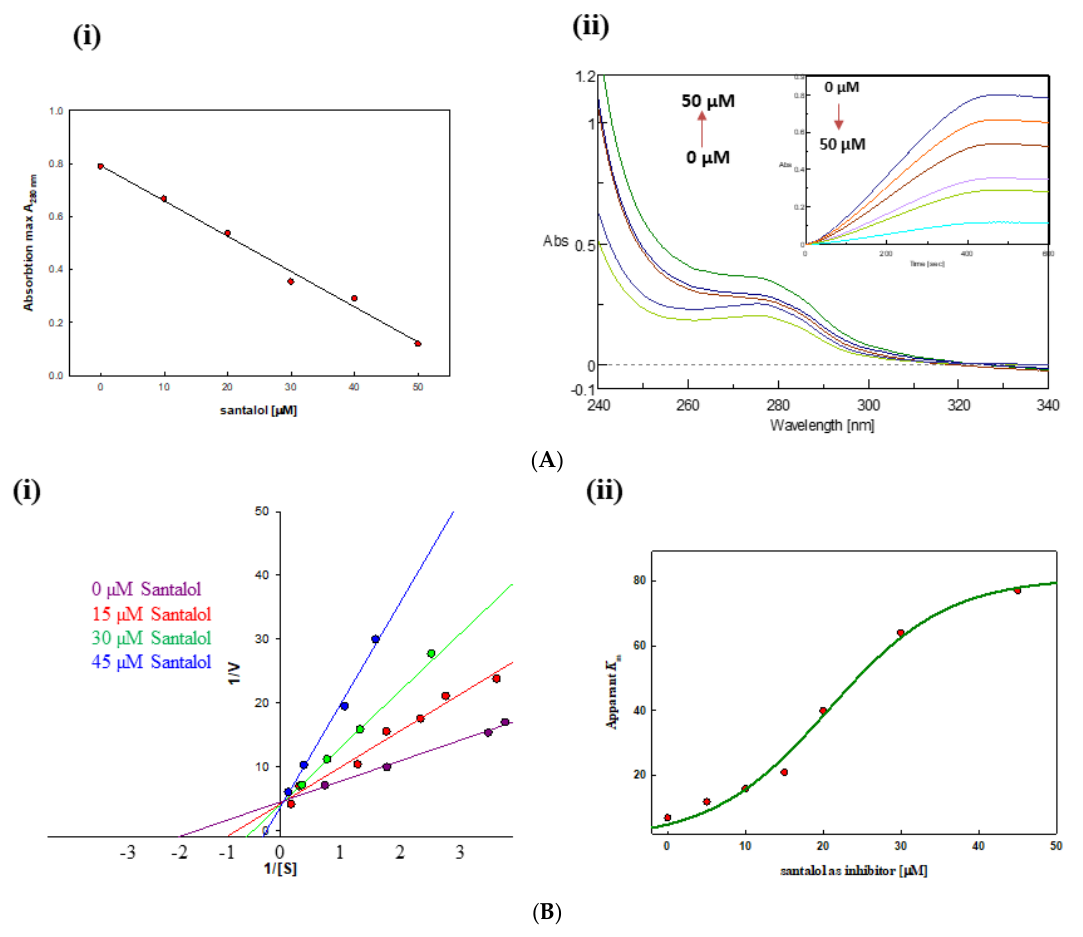
Figure 4. ( A ) ( i ) Effect of various concentrations of compound santalol as tyrosinase inhibitor on absorbance maxima A 280 nm values. ( ii ) Effects of varying concentrations of santalol on tyrosinase tertiary structure monitors using near-UV visible spectroscopic scan, with inset figure showing pro- gressive tyrosinase inhibition with increase in santalol concentration (µMolml −1 ). ( B ) ( i ) Lineweaver– Burk plot in presence of various concentrations of santalol, with right-hand side ( ii ) depicting increase in K m values were also observed in dose-dependent manner.